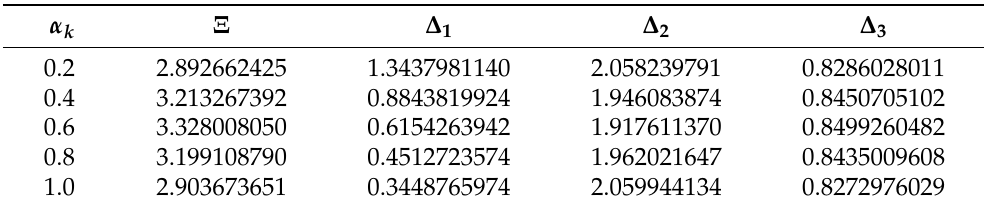
Table 1. Numerical values of Ξ and ∆ i , i = 1,2,3, for α k ∈ { 0.2,0.4,0.6,0.8,1.0 } when φ k ( t ) = ln ( t + k + 2 ) , β k = 3 k + 2 , and ρ k = k + 2 for k = 2 10 2 k + 2